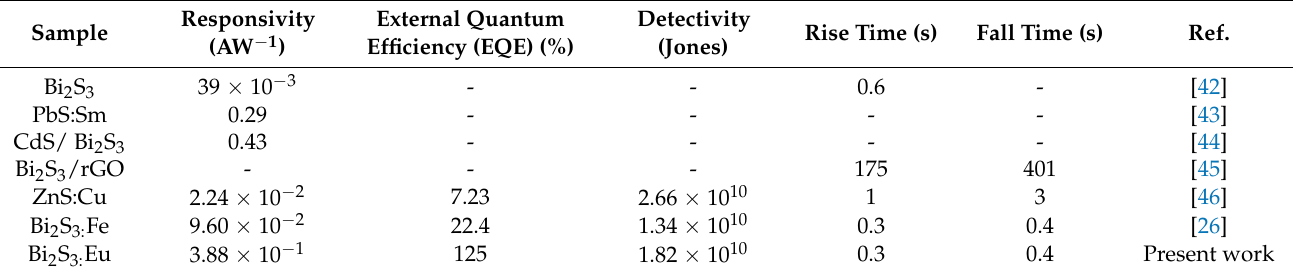
Table 2. Comparison of the photosensor parameters of the current work with the previous sulfide- related photodetectors.